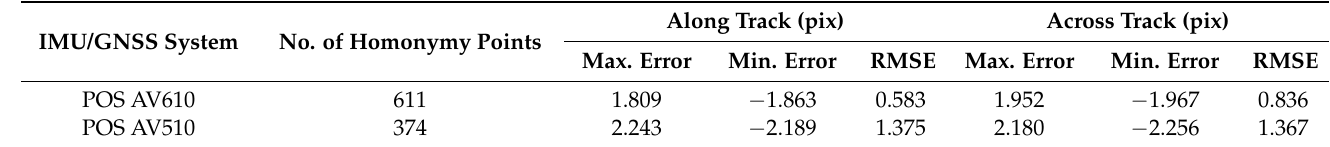
Table 9. Relative orientation residual of EA-stable-4 (left-middle image).